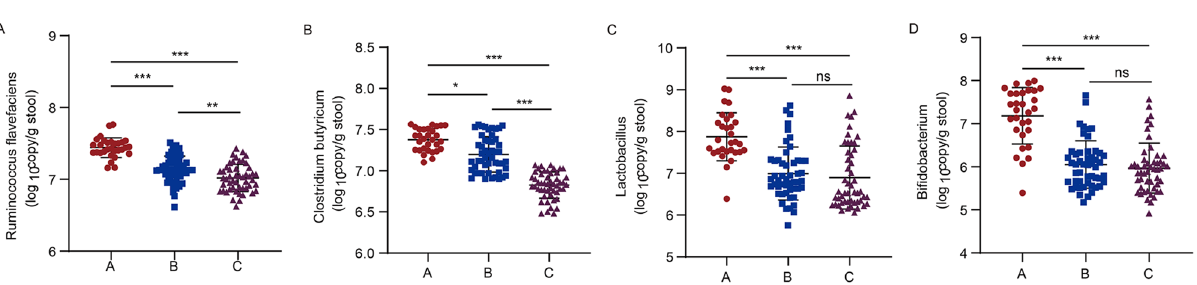
Figure 7. DNA copy numbers of Ruminococcus flavefaciens , Clostridium butyricum , Lactobacillus , and Bifidobacterium . DNA copy numbers of (a) Ruminococcus flavefaciens , (b) Clostridium butyricum , (c) Lactobacillus , and (d) Bifidobacterium in healthy child ( A , n = 30), child with nonwheezing MPP ( B , n = 50), and child with wheezing MPP ( C , n = 50) were measured by qRT-PCR. One-way ANOVA test was used for a and Kruskal–Wallis test was used for b–d. * P < 0.05, ** P < 0.01, *** P < 0.001. ns, not significant.